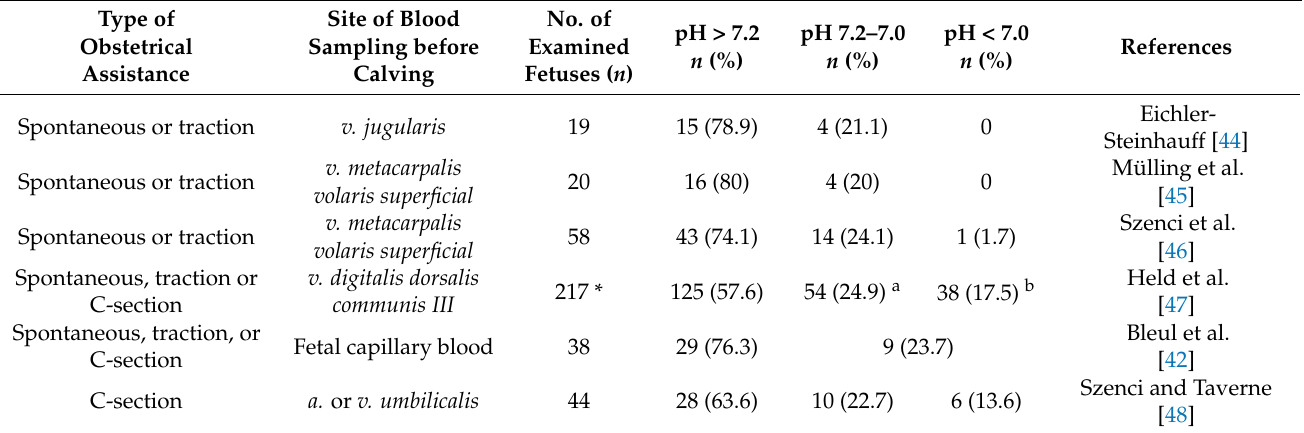
Table 1. Prevalence of physiological, moderately, and severely acidotic fetuses before starting obstetrical